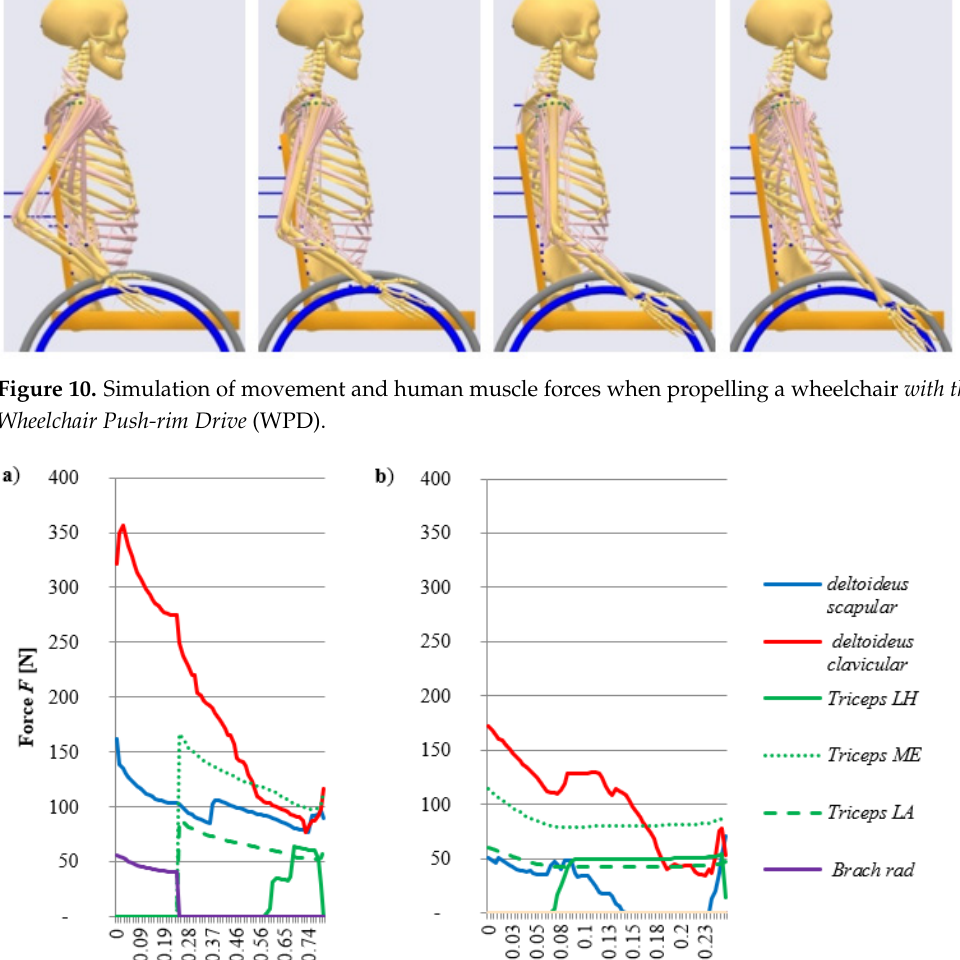
Figure 11. Forces in the upper limb muscles during one propulsion cycle (without the return phase): ( a )—the wheelchair with the Wheelchair Cam-thread Drive (WCD); ( b )—the wheelchair with the Wheelchair Push-rim Drive (WPD).